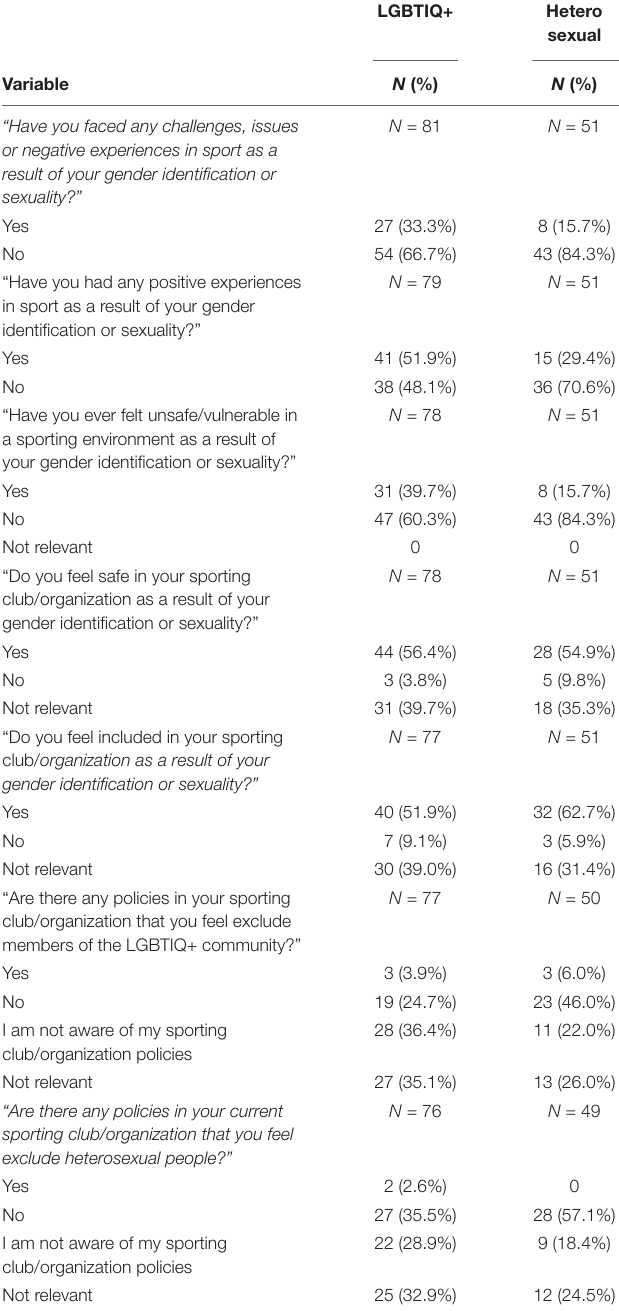
TABLE 2 | Summary of experiences in